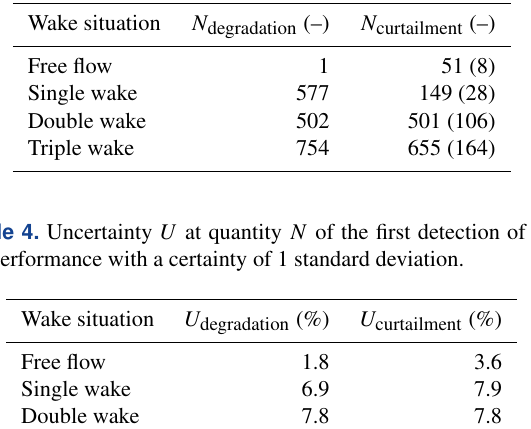
Table 3. N values to the first detection of underperformance with a certainty of 1 standard deviation. Values in brackets indicate N with wind speeds above the curtailment.